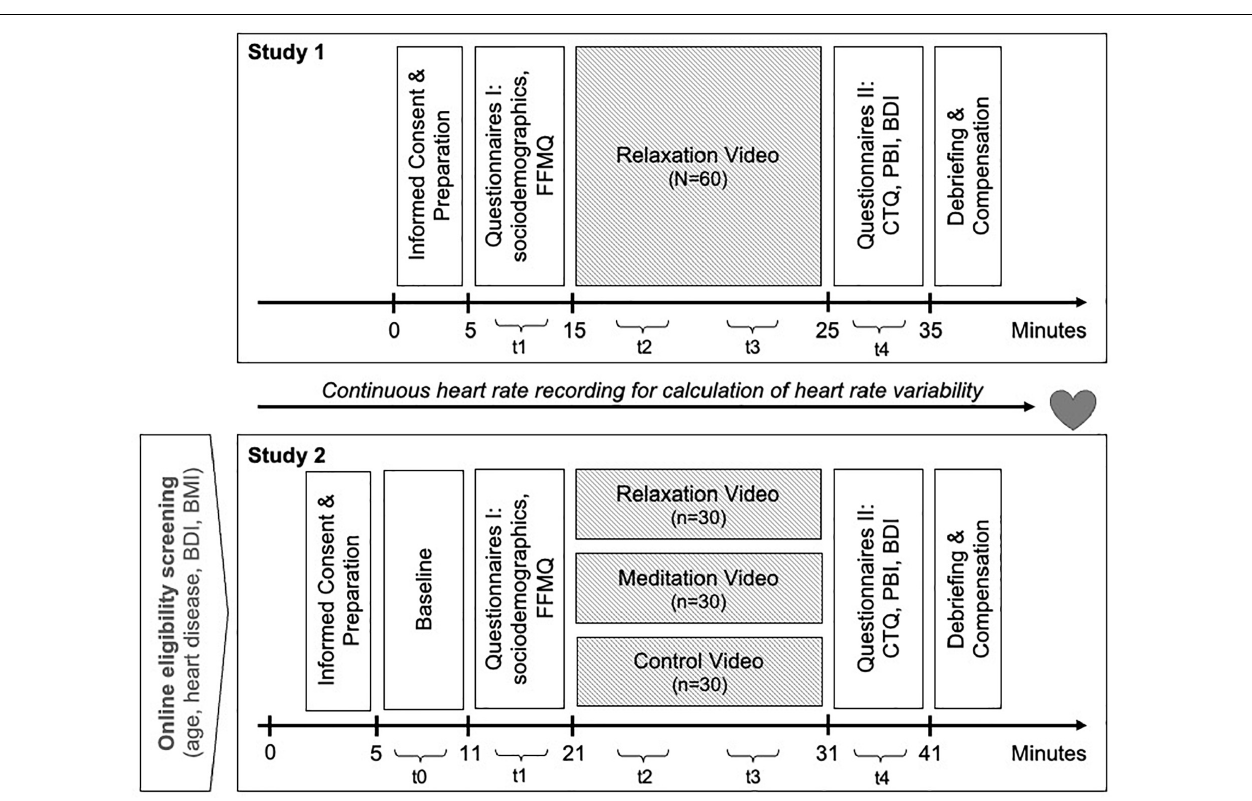
FIGURE 1 | Schematic representation of the study design for study 1 and 2; t0 – t4: 180-sec time segments that were extracted from the continuous heart rate recording for calculation of heart rate and heart rate variability resulting in four time points for the multiple growth curve analysis in Study 1 and five time points in Study 2. A comprehensive list of all measures assessed during both studies can be found at